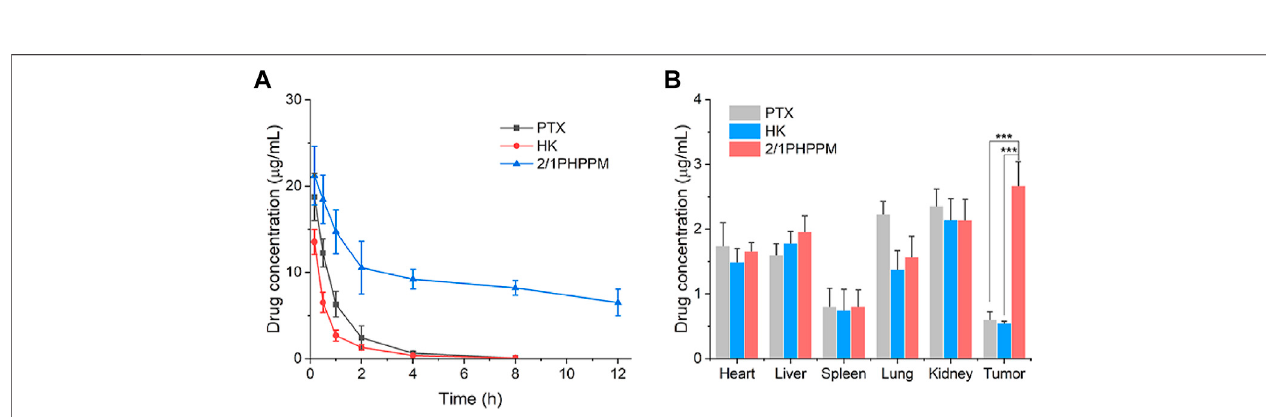
FIGURE 6 | Blood circulation (A) and in vivo biodistribution (B) of paclitaxel, honokiol, and 2/1PHPPM. Data are represented as mean ± standard deviation, n = 3. *** p < 0.001.